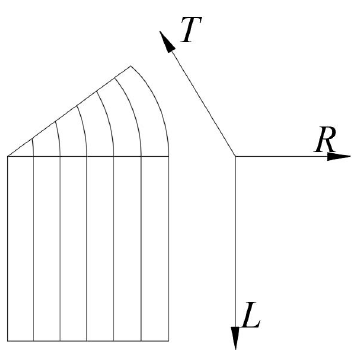
Figure 4. Three-dimensional image of Glulam.